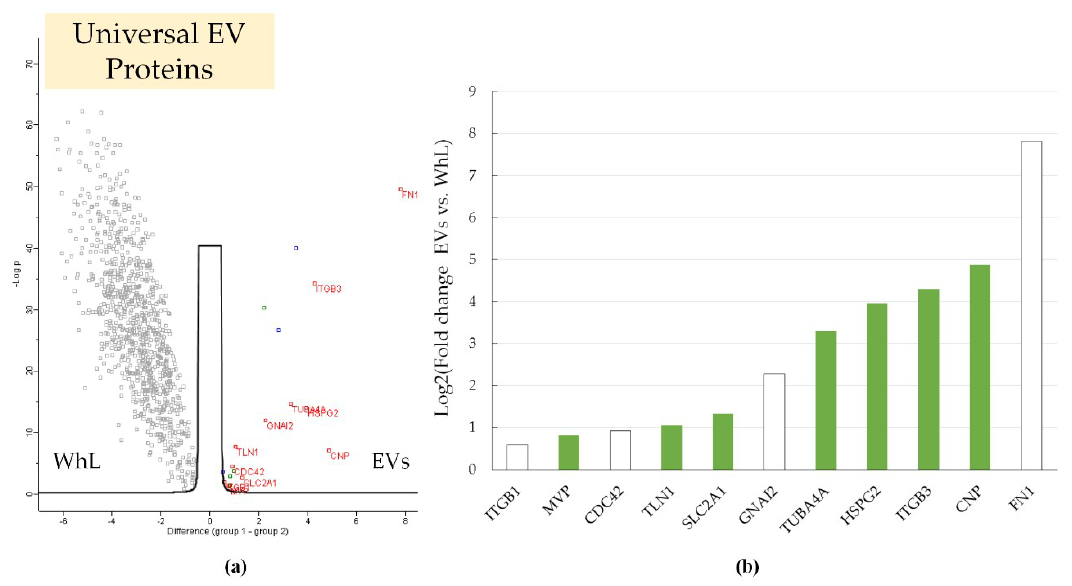
Figure 2. ( a ) Volcano plot that shows the differences in the protein abundance in the EV fraction (in red) and in the whole lysate (WhL) (in black) for all cell lines studied. A total of 933 proteins were identified by at least 4 unique peptides per protein and were statistically significant (Student’s t -test, truncation: permutation-based FDR = 0.01, S0 = 1, Perseus 1.6.0.7 software (Max Planck Institute of Biochemistry, Martinsried, Germany). EV markers (11 proteins) are shown by their gene names in red. Normalized data of label free quantification (LFQ) intensities were used for visualization of the protein level. The LFQ intensities were log2 transformed. Differences in protein abundance (considering the log2 transformation) are provided on the x-axis, while -Log p (log10 transformed p -value) is plotted on the y-axis. The blue dots represent proteins APOB, HBB, and HIST1H4A that could be artefacts of exosome isolation. Detailed data are presented in the Supplement 2; ( b ) universal EV protein markers were more abundant in the EV samples compared to WhL samples; the log2 transformed fold change that reflects the difference in protein abundance is plotted on the y-axis; proteins included in the ExoCarta Top100 list that contains the most often identified in exosome molecules (http://exocarta.org/exosome_markers_new) are shown in white.